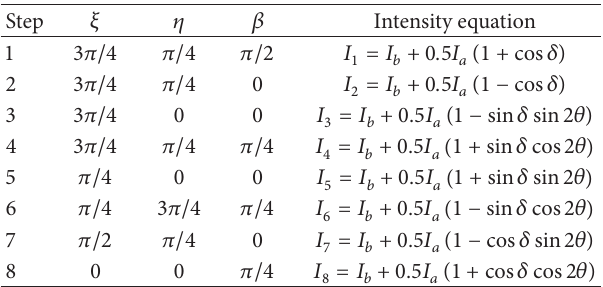
Table 1: Optical arrangements for the eight-step phase-shifting